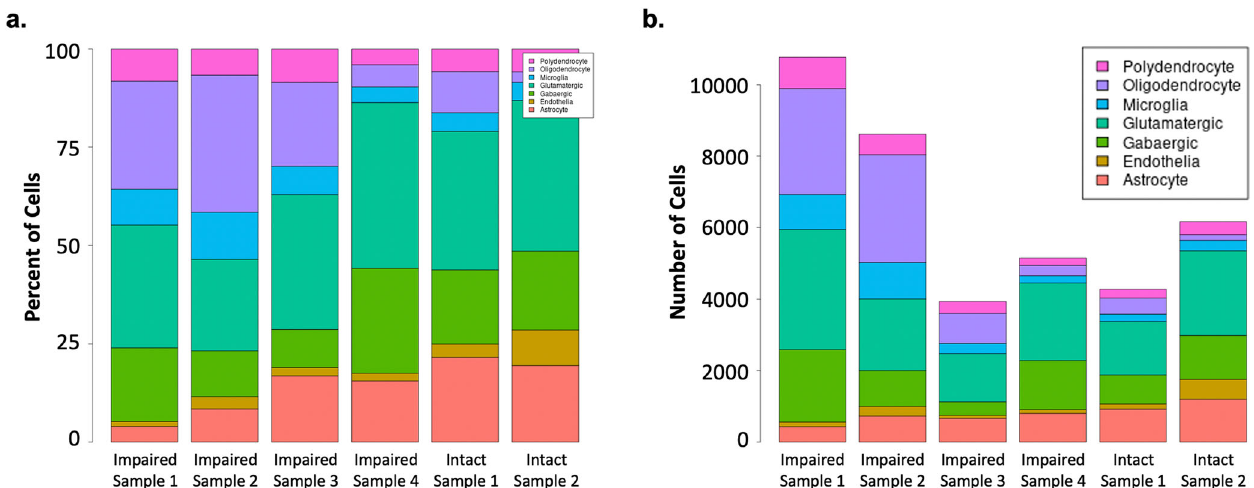
Fig. 1 Histogram demonstrating clusters of nuclei by cell type and by patient. Plots of cells from temporal lobe tissue of individual patients with and without memory impairment by ( a ) percent and ( b ) number of each cell